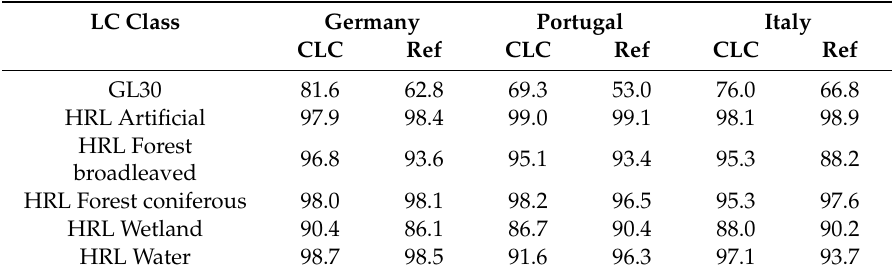
Table 4. Overall accuracies (%) for the modified CLC classification and reference data